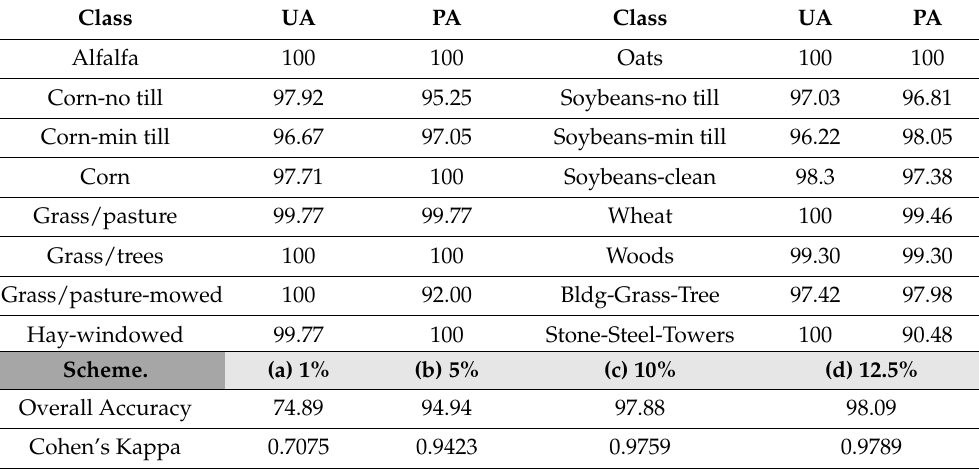
Table 3. User’s and Producer’s accuracy results (using 10% of the available training sample for the dataset), Overall accuracy and Cohen’s Kappa of the HDCA with different schemes on the Indian Pines dataset.